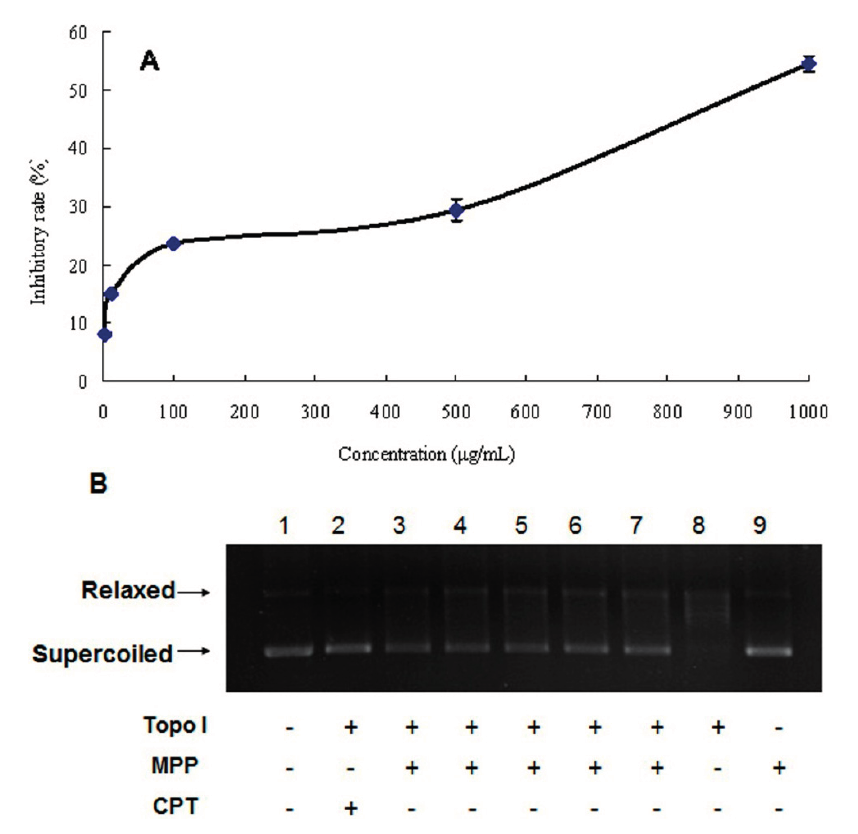
Figure 4. Antitumor activity of MPP, ( A ) Inhibitory effect of MPP on A549 cell lines; ( B ) Effect of MPP on the relaxation activity of topoisomerase I (Topo I). Lane 1, DNA alone (no topo I and no MPP); Lane 2, camptothecin (CPT) at concentration of 50 μ g/mL + DNA + topo I; Lane 3–7, MPP at concentrations of 25, 50, 100, 200 and 400 μ g/mL + DNA + topo I, respectively; Lane 8, topo I + DNA; Lane 9, DNA + 200 μ g/mL